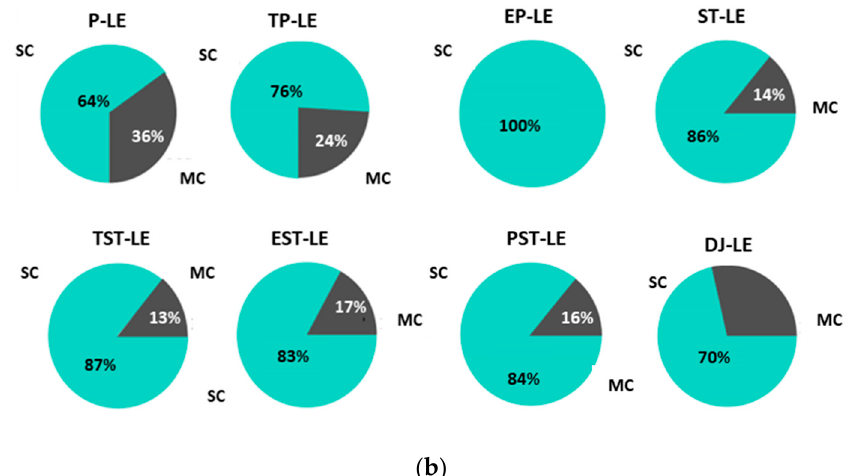
Figure 8. ( a ) System configuration vs. learning effect approach. ( b ) Learning effect approach vs. objective function types.